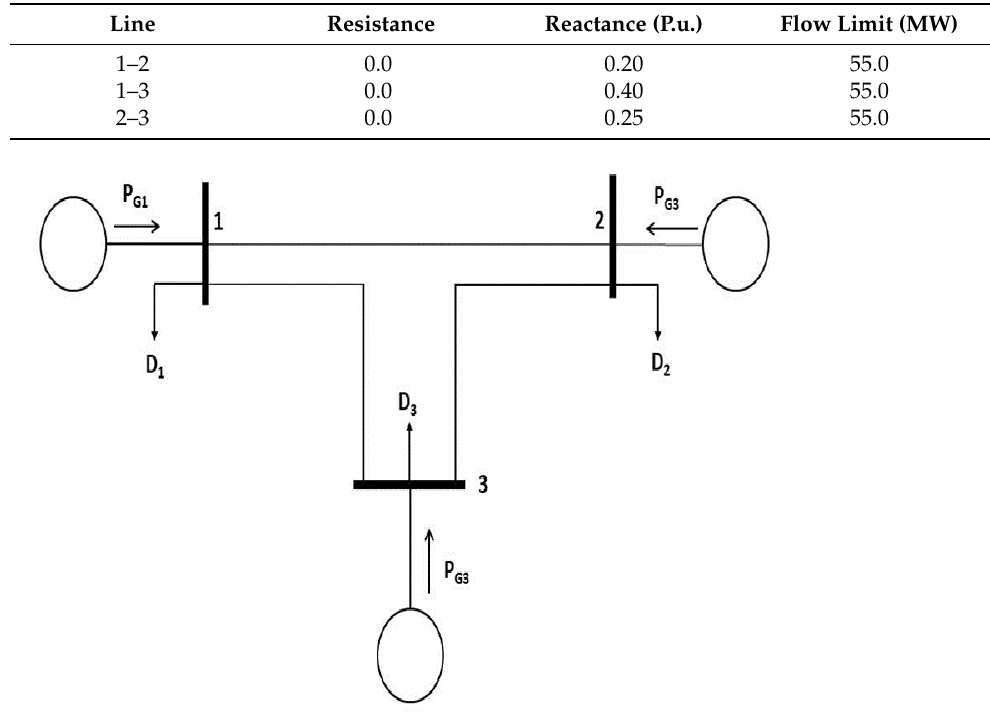
Table 2. Transmission lines parameters.